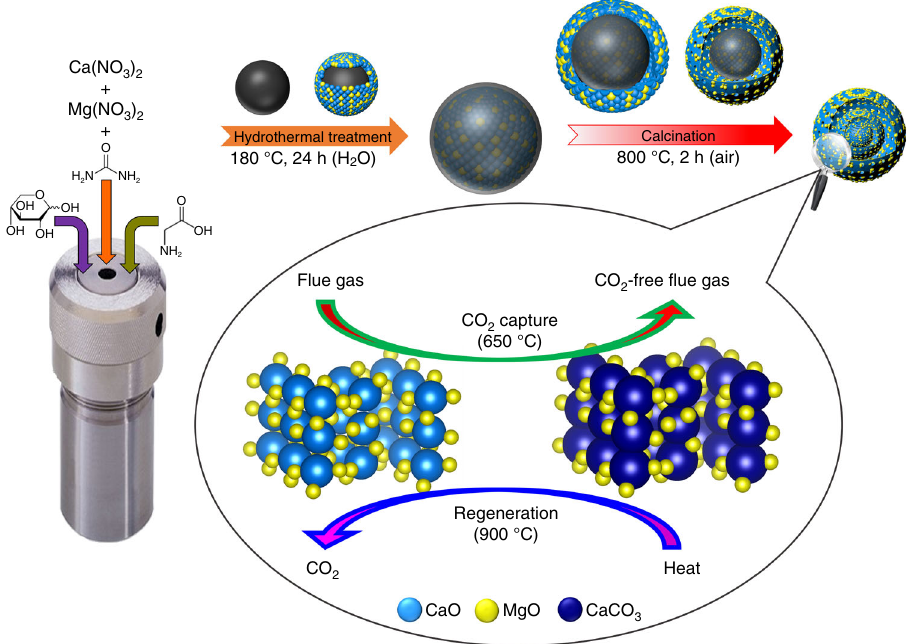
Fig. 1 Synthesis protocol. Schematic illustration of the hydrothermal approach developed here to synthesize template-assisted, MgO-stabilized, CaO-based CO 2